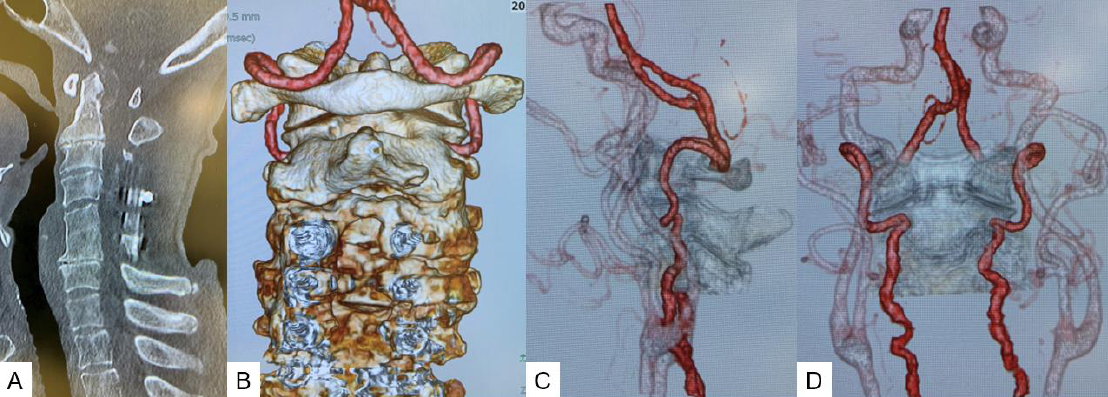
Figure 2. Preoperative CT and vascular images, ( A ): mid-sagittal reconstruction CT, ( B ): posteroan- terior 3D CT image including arteries, ( C ): lateral VA image, ( D ): posteroanterior VA image.